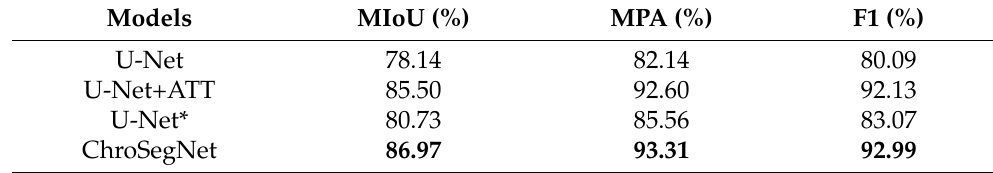
Table 6. Segmentation performance of different modules based on the baseline model (U-Net).